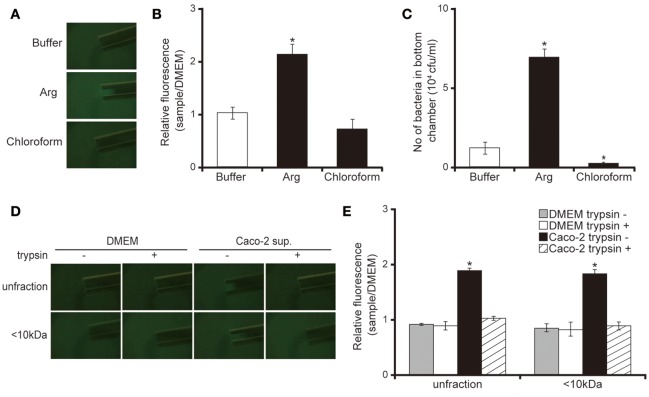
Caco-2 cell supernatant attracts the P. aeruginosa PAO1 strain. (A) A glass slide surface was filled with a P. aeruginosa PAO1 strain expressing a green fluorescent protein (GFP). Capillary tubes were filled with buffer (control), Arg (attractant), or chloroform (repellent). The accumulation of the P. aeruginosa PAO1 strain expressing GFP at the capillary tip was visualized and photographed by microscopy at a magnification of 40×. (B) The graph shows the relative intensity of GFP in the capillary after incubation for 10 min. Error bars indicate standard error (n = 3). *P < 0.05 compared with buffer. (C) A buffer (control), Arg (attractant), or chloroform (repellent) filled the bottom chamber of Transwell. The P. aeruginosa PAO1 strain was added and, after 3 h, the numbers of bacteria in the bottom chambers were counted. Error bars indicate standard error (n = 3). *P < 0.05 compared with buffer. (D) A 15-day Caco-2 cell supernatant and Dulbecco's modified Eagle medium (DMEM; control) were filtered through 10-kDa MW cut-off membranes. The <10 kDa fraction or unfiltered samples were treated with or without trypsin (trypsin + or −). A cover glass surface was filled with the P. aeruginosa PAO1 strain expressing GFP. Capillary tubes were filled with the treated samples. The accumulation of the GFP-expressing P. aeruginosa PAO1 strain at the capillary tip was visualized and photographed by microscopy at a magnification of 40×. (E) The graph shows the relative intensity of GFP in the capillary tube after incubation for 10 min. Error bars indicate standard error (n = 3). *P < 0.05 compared with DMEM of the same fraction size.